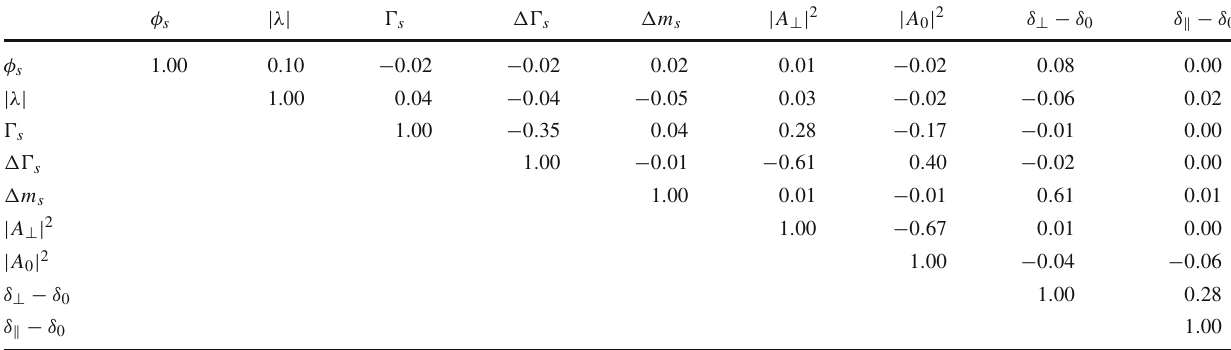
Table 6 Correlation matrix for the results in Eq. (16) taking into account correlated systematics between Run 1 and the 2015 and 2016 results